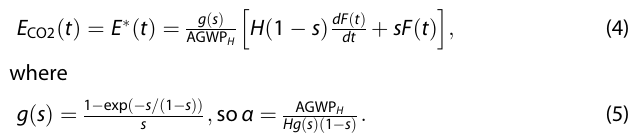
The function g ( s ) is approximately unity for small s , and is implicitly approximated to unity by CLA, but it actually has a value g = 1.13 for s = 0.25 and H = 100 years.